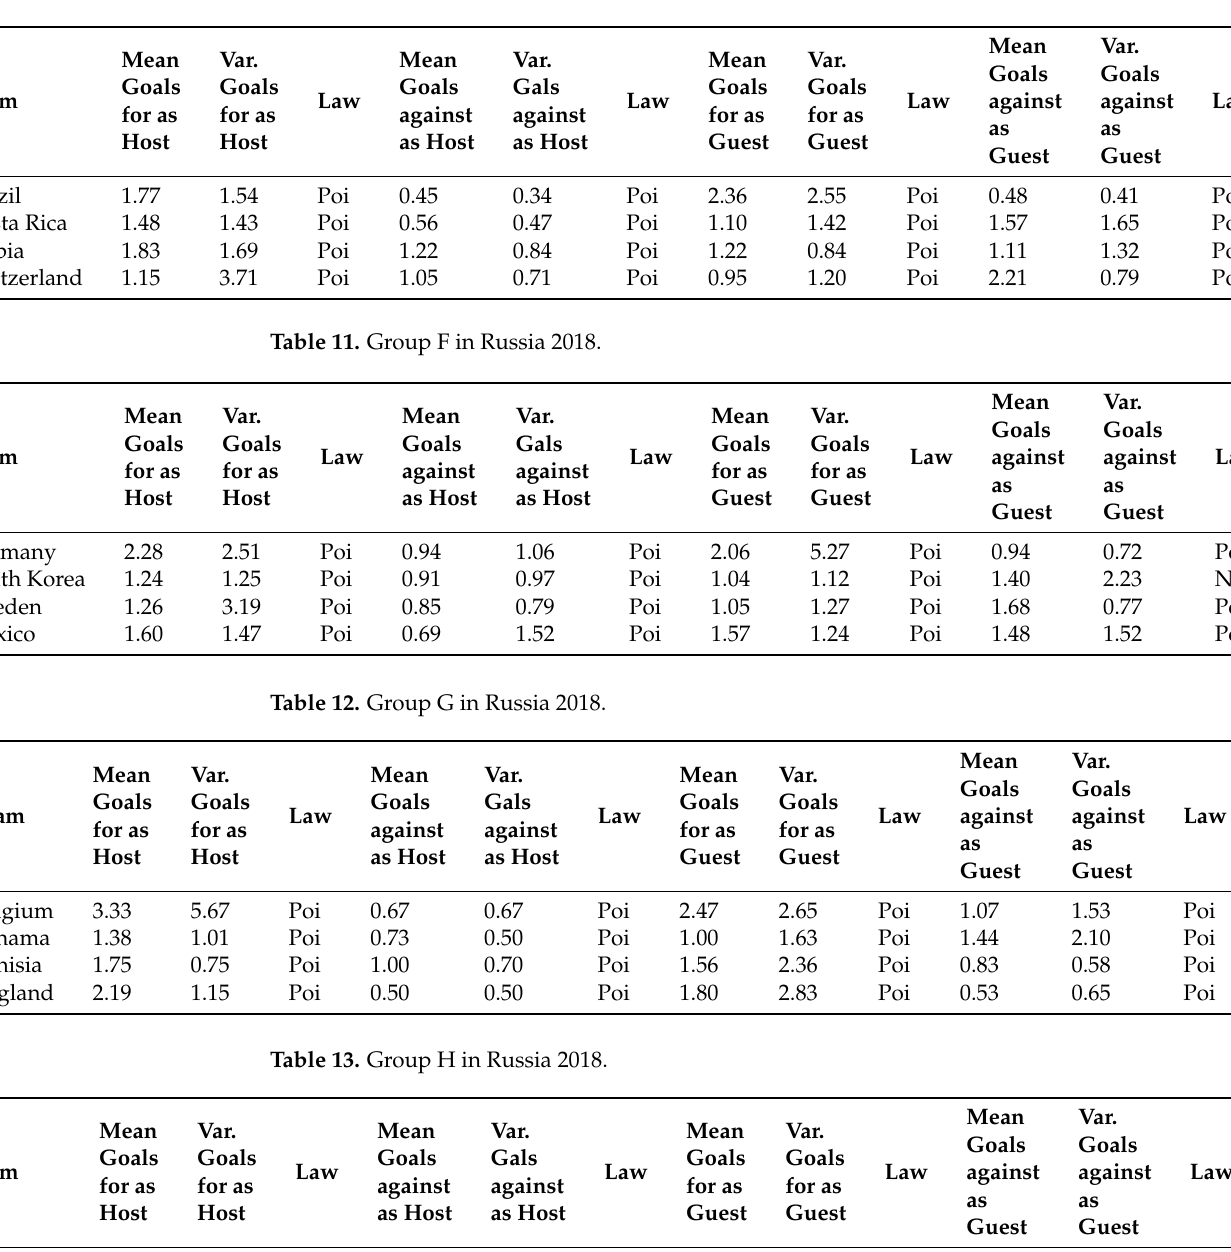
Table 10. Group E in Russia 2018.